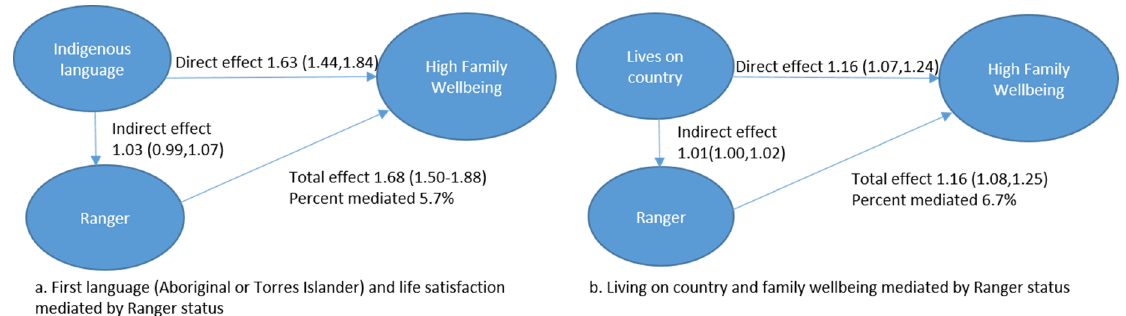
Figure 1. Directed Acyclic Graph showing relationships between life satisfaction and cultural factors (( a ). first language, ( b ) living on country) mediated by Ranger.